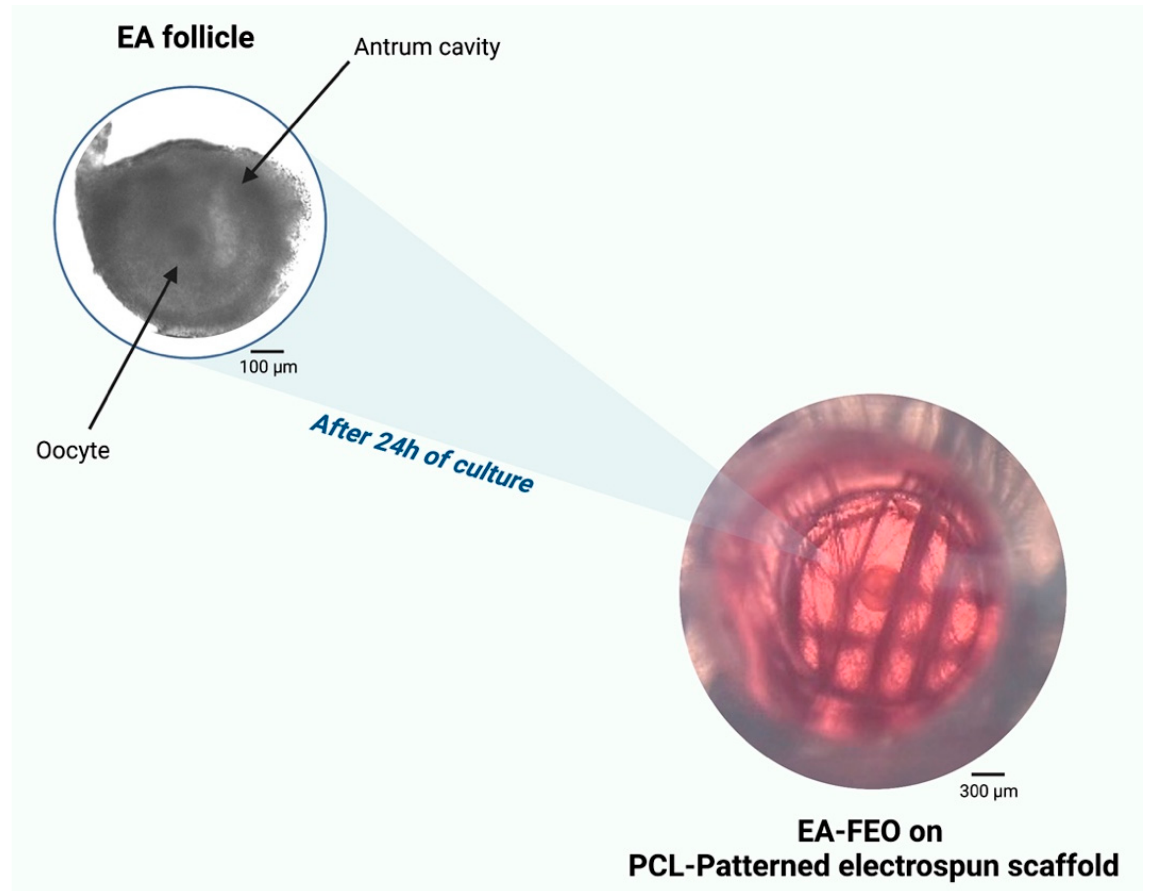
Figure 3. An example of EA incubated as FEO for 24 h on PCL-Patterned electrospun scaffolds in the absence of any hormonal stimulation.